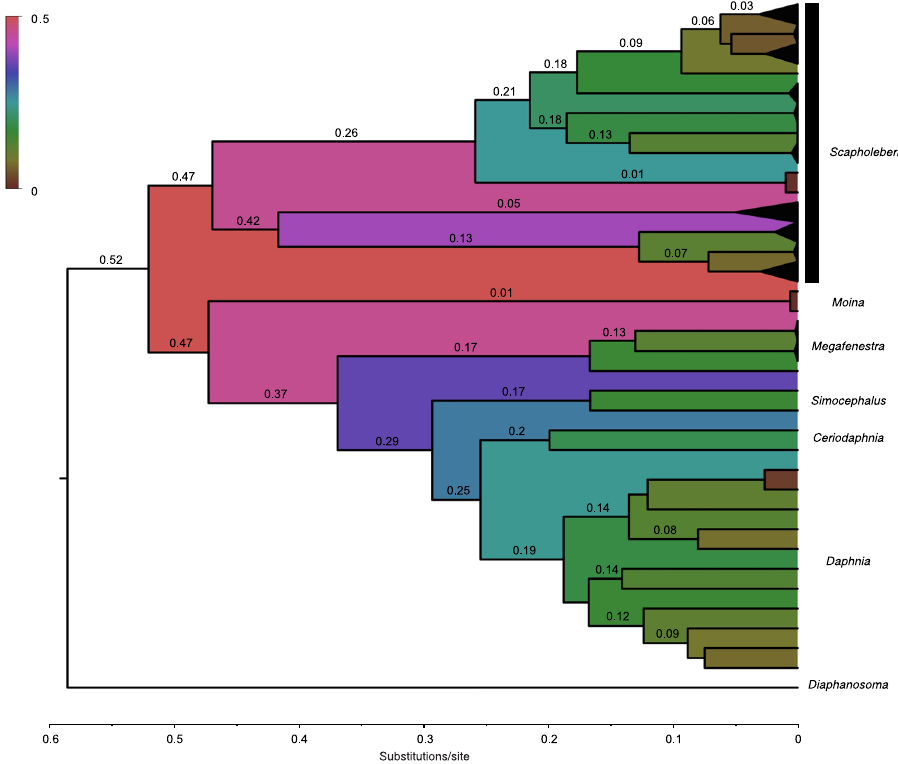
Figure 6. Time tree of mitochondrial sequence variation in neustonic ( Scapholeberis and Megafenestra ) and non-neustonic daphniids. The graph shows the relative rates of genetic divergence in substitutions/site (numbers on axis, branches and colors depict the same values) using a maximum likelihood tree as